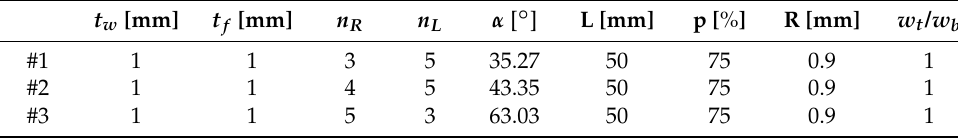
Table 2. Summary of the geometrical feature of the printed